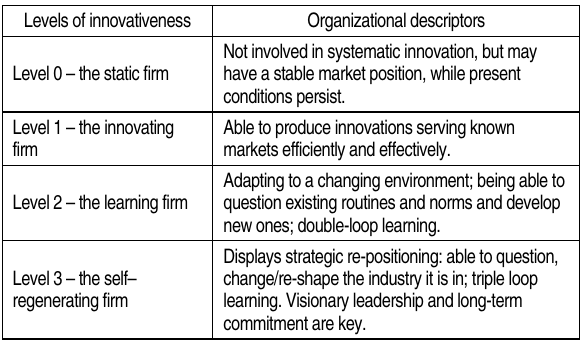
Table 1. Mathew’s criteria for